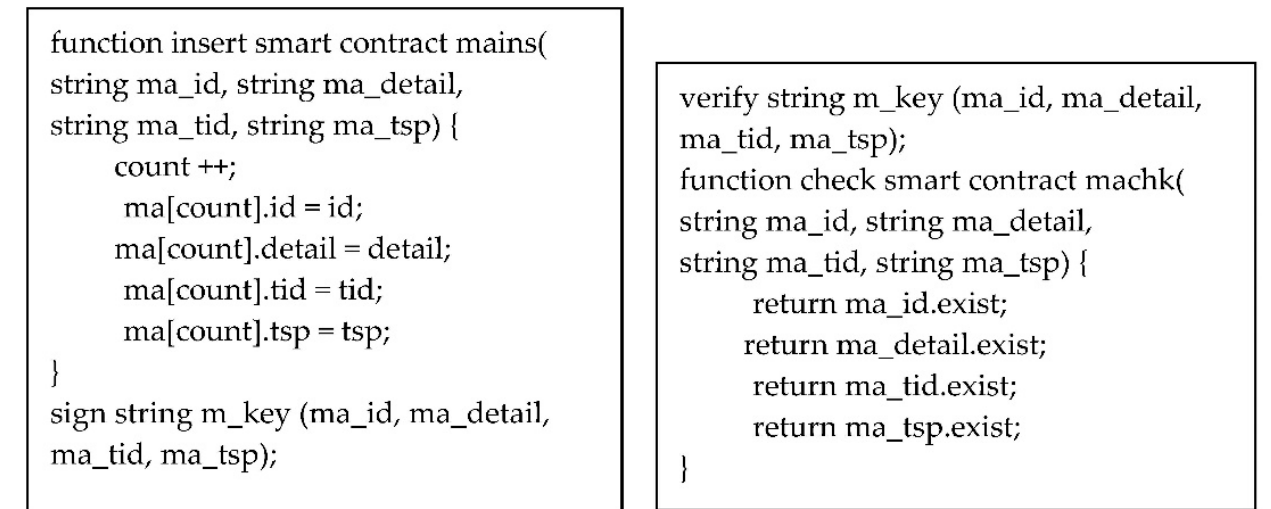
(65) Figure 9. Authentication and issuing invoice phase (CA to